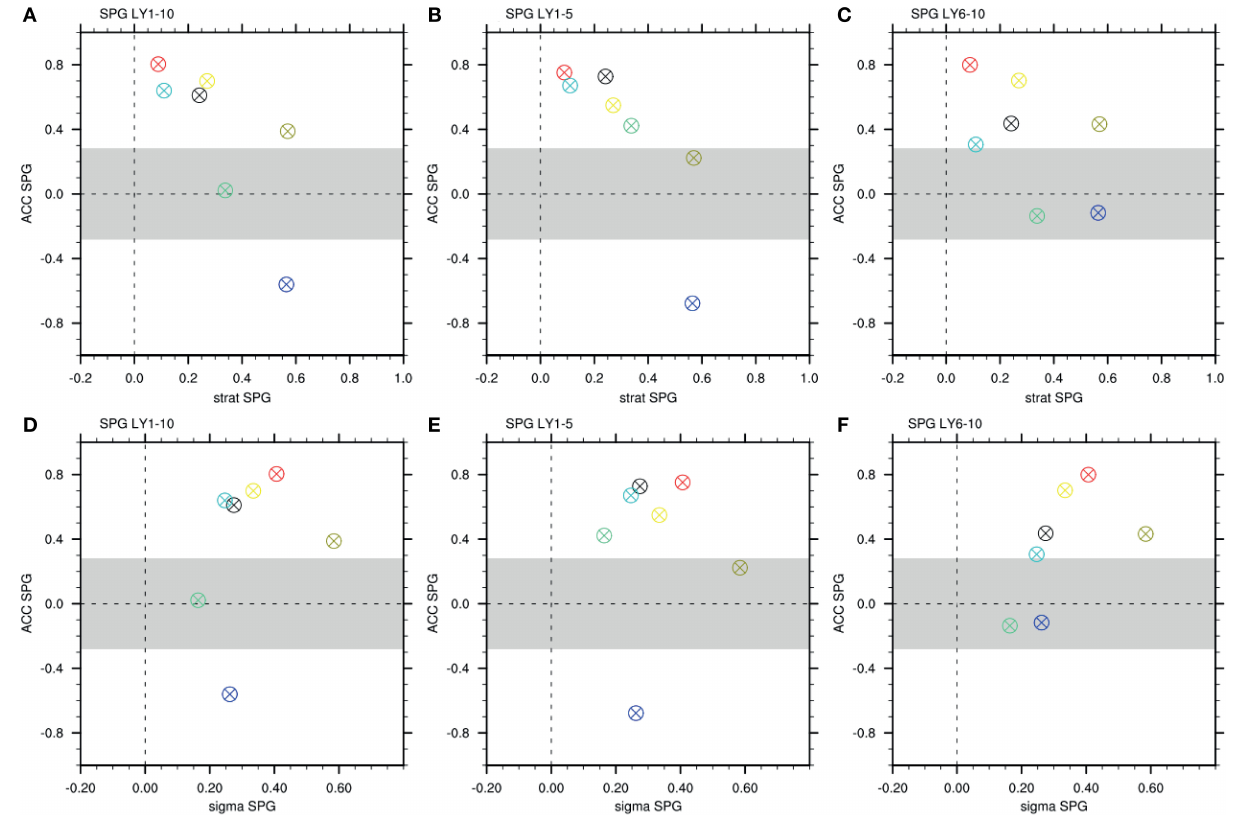
FIGURE 8 | ACC for SPG SST in seven initialized CMIP6 model systems at lead years (A) 1–10, (B) 1–5, and (C) 6–10 against RMSE between observed (vertical dashed line) and simulated SPG stratification in the period 1960–2014 from the corresponding historical simulations (x-axis). (D–F) as (A–C) , but showing the standard deviation of SPG SST in the first 500 years of the respective model’s piControl simulation on the x-axis. Colors indicate the individual models: blue = CanESM5, red = CESM-DPLE, brown = IPSL-CM6A-LR, black = HadGEM3-GC31-MM, cyan = MIROC6, yellow = MPI-ESM1.2-HR, green = NorCPM1. The gray area indicates insignificant prediction skill at the 5% significance level based on 1,000